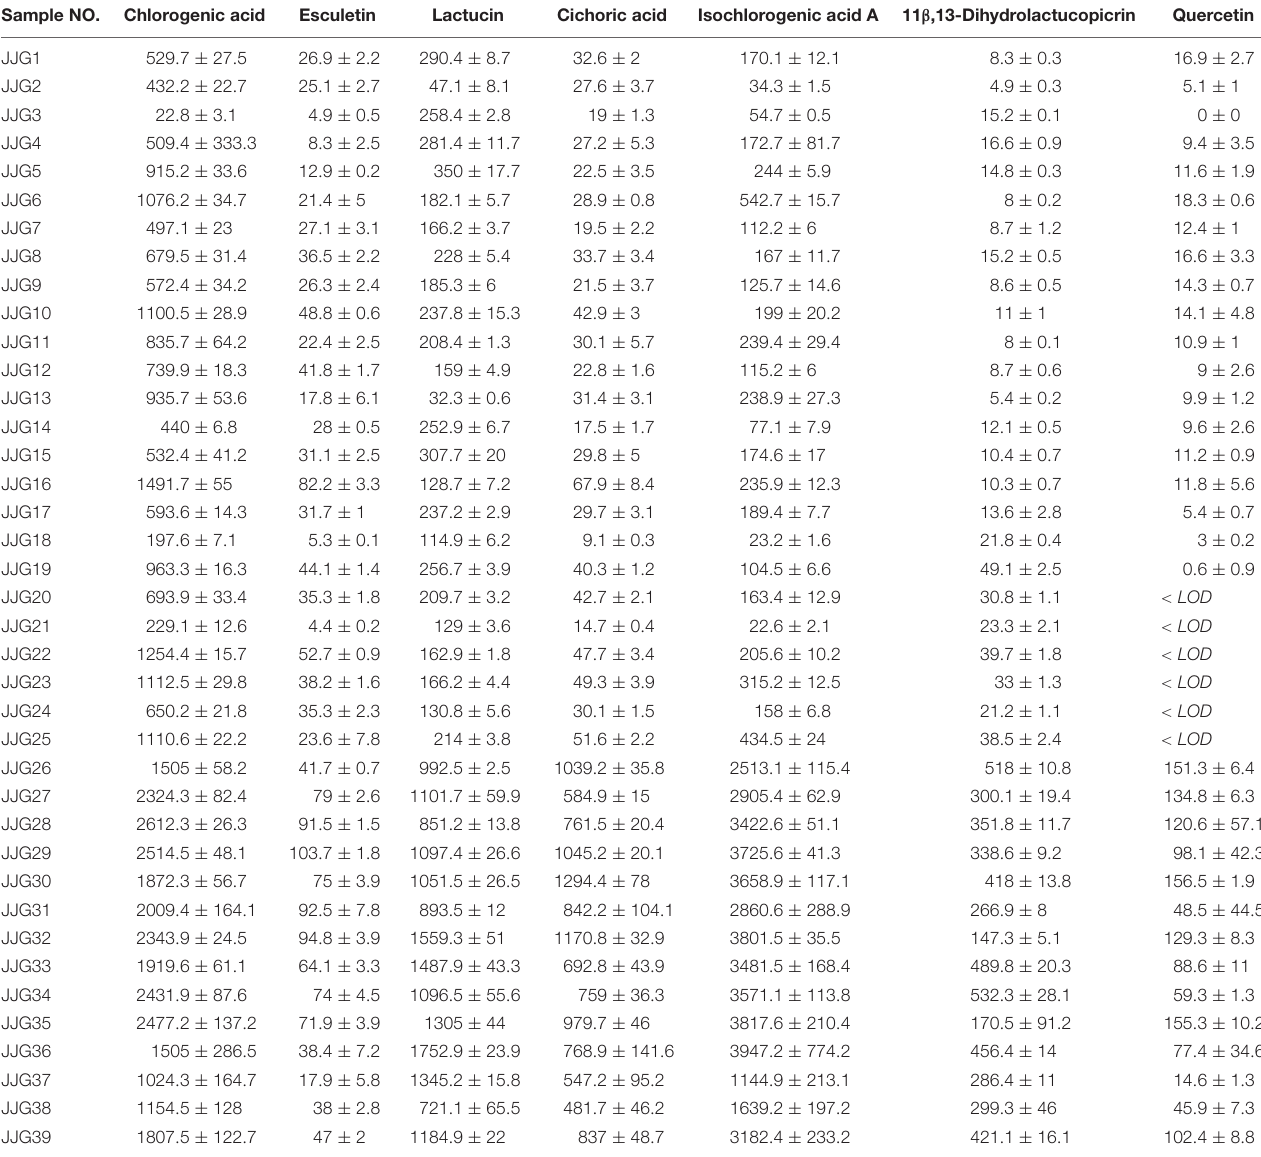
TABLE 3 | Content characteristics of seven compounds in roots of Cichorium intybus L. (mean ± SD, µ g/g). Sample NO. Chlorogenic